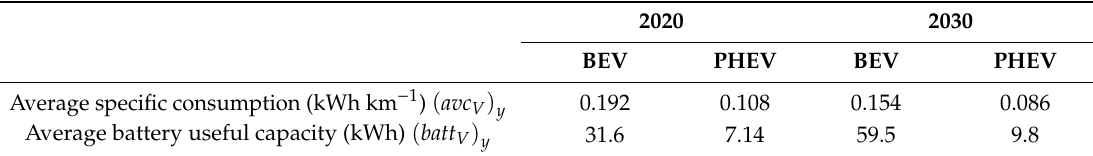
Table 6. xEV average consumption and capacity assumed forecast values.